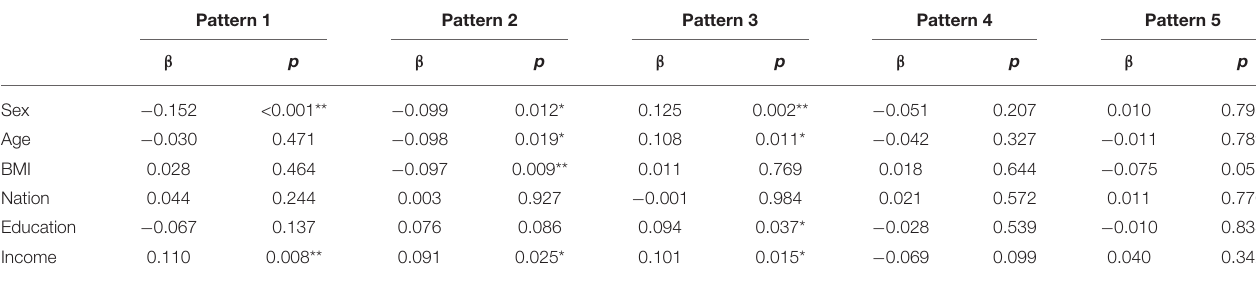
TABLE 5 | Association between dietary patterns and characteristic. Pattern 1